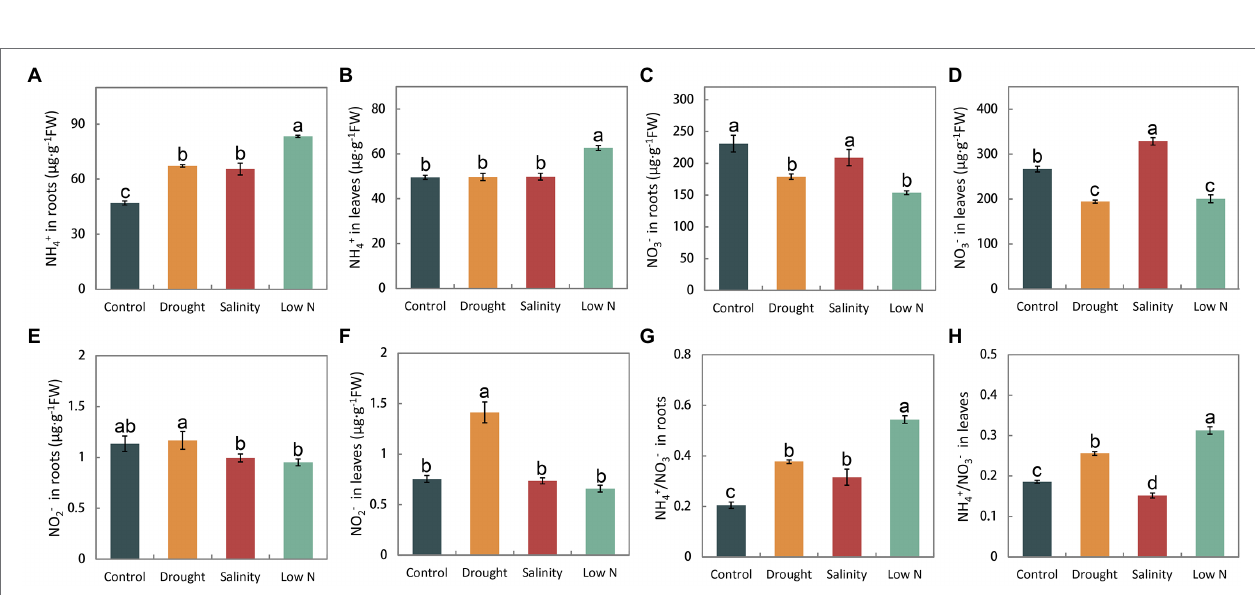
FIGURE 3 | NH 4+ , NO 3 − , and NO 2 − contents, as well as NH 4+ /NO 3 − in roots (A,C,E,G) and leaves (B,D,F,H) of S. japonica as affected by drought, salinity, and low N treatment. Data indicate means ± SE of three replicates (12 plants). Bars labeled with different letters indicate significant differences between treatments ( p <